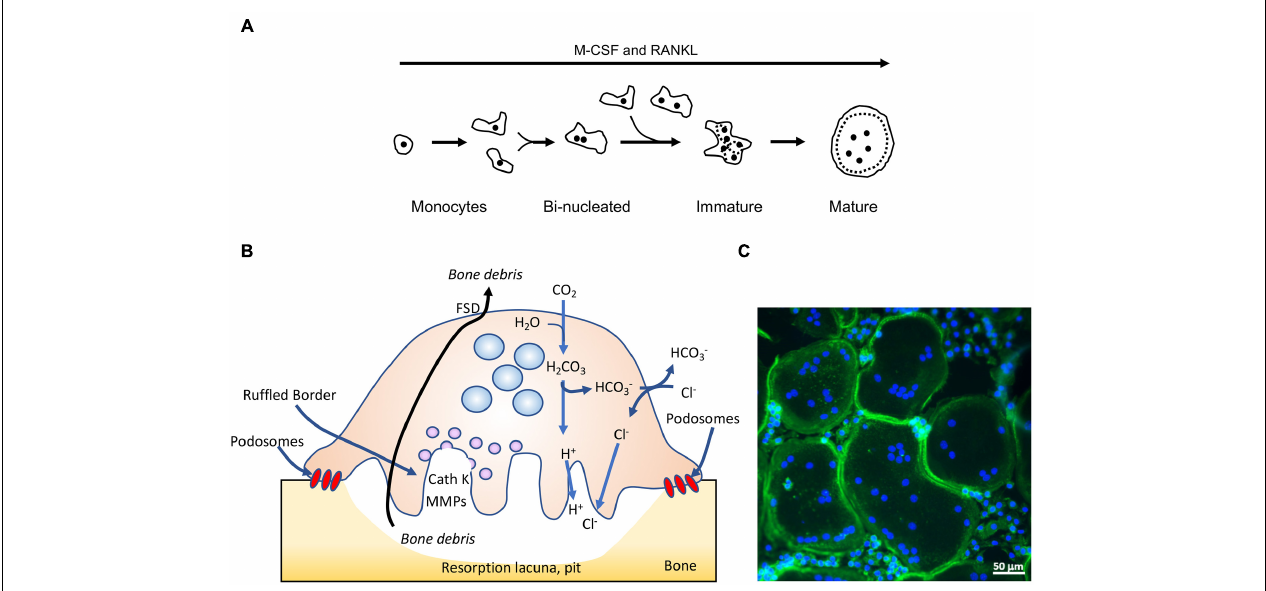
FIGURE 1 | Osteoclasts: form and function. (A) Outline of osteoclastogenesis in culture. M-CSF and RANKL induce mononucleated monocytes to differentiate and fuse to form bi-nucleated cells, which continue to fuse and form immature, multi-nucleated cells characterized by their random organization of podosomes (small black dots). The immature cells then mature and become rounder, and display a podosomal sealing zone-like belt at their periphery. (B) Schematic drawing of a mature, bone-resorbing osteoclast. OCLs adhere to bone using podosomes, actin-rich adhesion structures that, when grown on mineralized matrix, form a closed array (sealing zone) that isolates the area of bone that is to be degraded. The cells then secrete from their ventral ruffled border membrane protons, which dissolve the mineral components of the bone matrix, and proteases [such as cathepsin K (CathK) and matrix metalloproteases (MMPs)] that degrade its protein components. This combined activity results in formation of a resorption lacuna, or pit, in the bone surface. OCLs then endocytose the bone degradation products through their ruffled border membrane, transport them through the cell, and secrete them from the apical Functional Secretory Domain (FSD). (C) Mature mouse OCLs grown on glass coverslips, stained for actin (green, highlights the closed podosomal sealing zone-like array) and DNA (blue, nuclei). Note much smaller cells that have not fused and are located between the larger OCLs. Panels (B,C) were modified with permission from Shalev and Elson